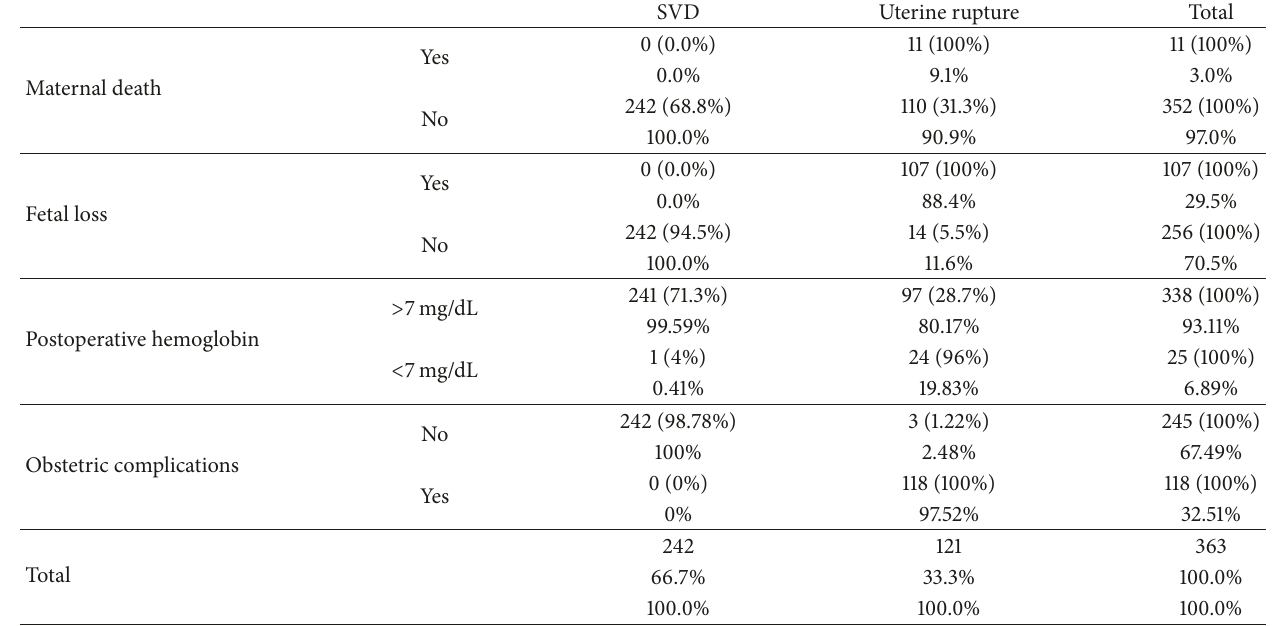
Table 3: Frequency distributions of bad outcomes of uterine rupture in MTUTH, MTU, 2016.